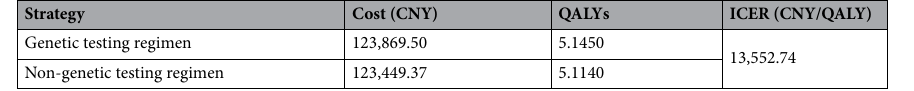
Table 1. Cost and QALYs per capita in base-case analysis. CNY Chinese Yuan Renminbi, QALYs quality- adjusted life years, ICER incremental cost-effectiveness